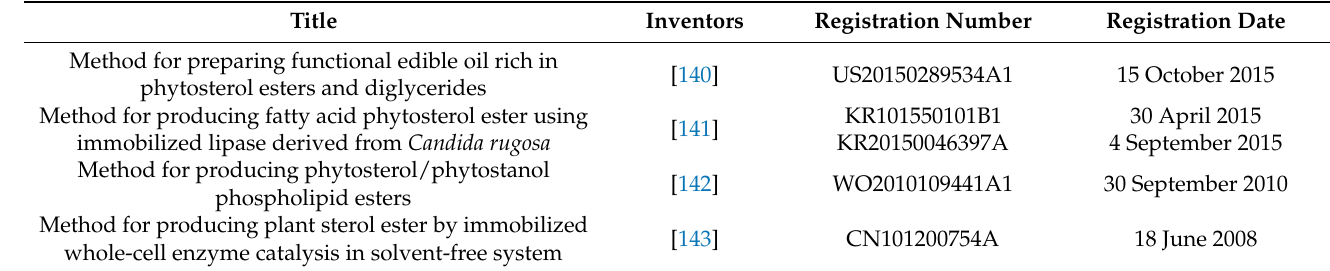
Table 2. Patents registered in the last 20 years about the synthesis of phytosterol